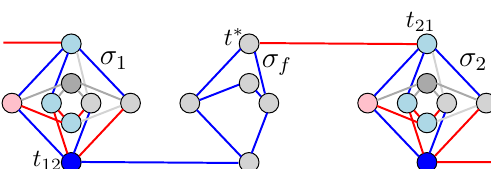
Figure 13. Figure illustrating a connection between two perfect cells by a chain of bad-cell vertices and edges. Colors on the vertices and edges encode the values of the corresponding coefficients, where blue is for negative, red for positive, and gray is for near-zero, and the intensities of colors encode the magnitudes. The couplers of cell σ f are all set to − 1 forcing t 12 and t ∗ to take the same values in an optimal solution.